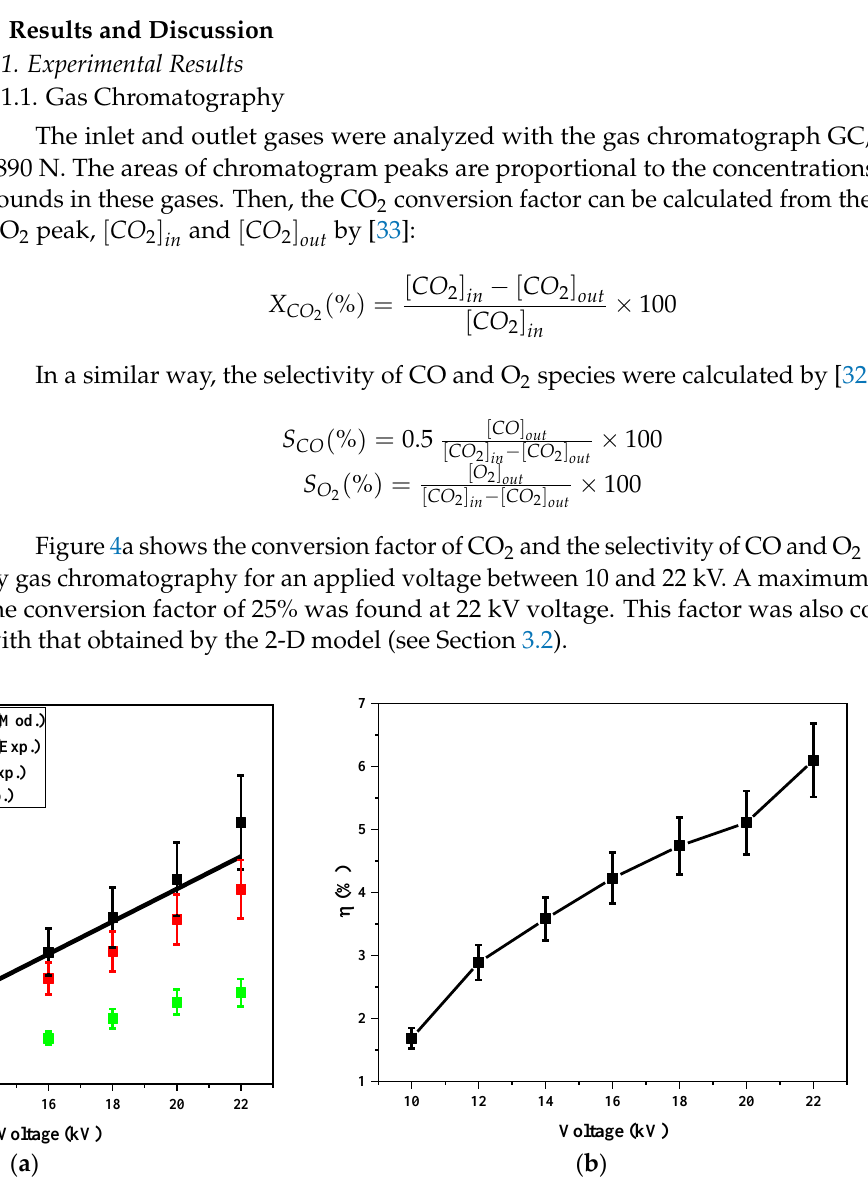
Figure 4. ( a ) Dependence of CO 2 conversion and CO/O 2 selectivity on applied AC voltage. ( b ) Experimental dependence of energy efficiency on applied AC voltage.